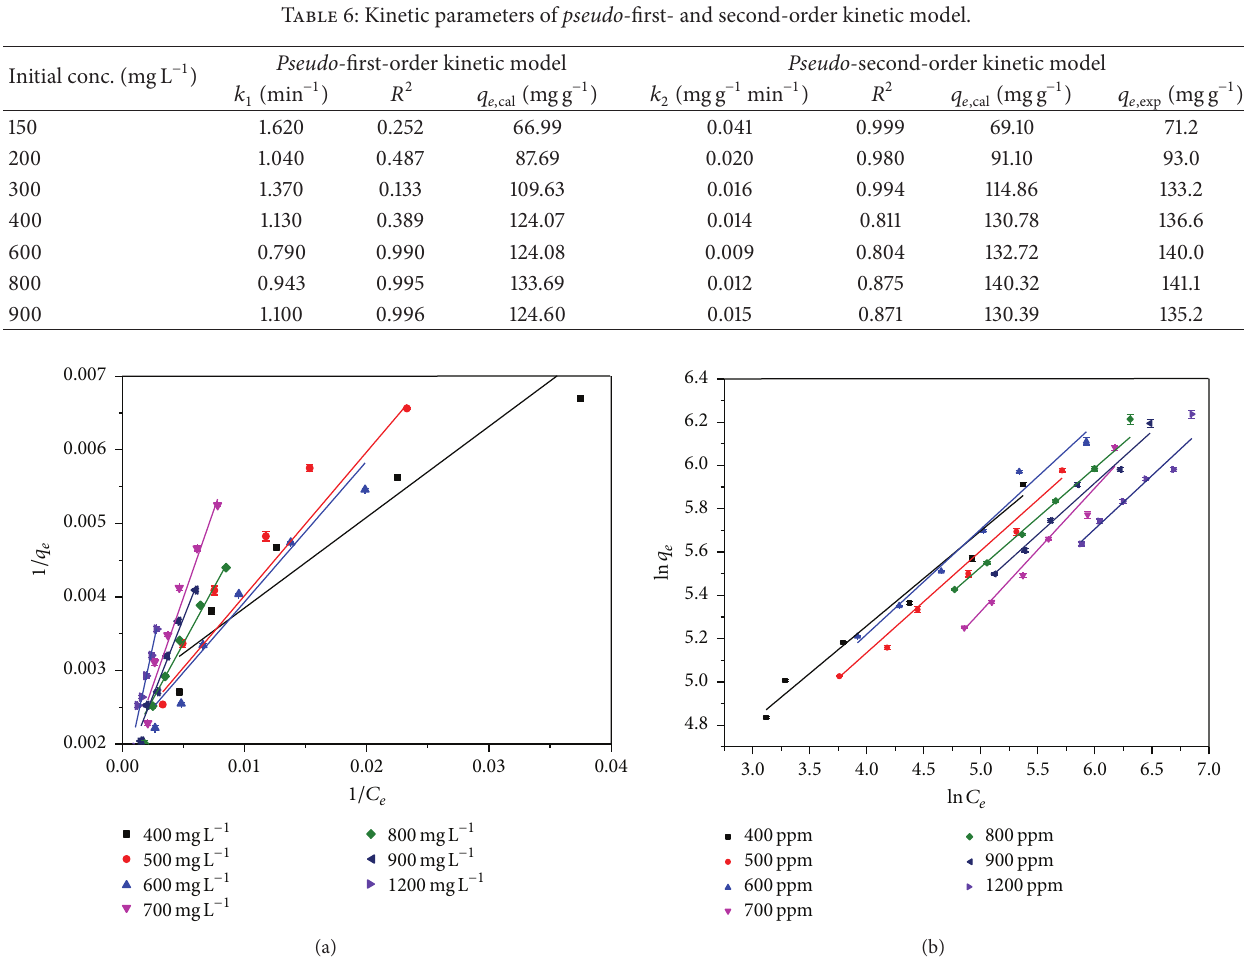
Figure 4: Plots of Langmuir (a) and Freundlich (b) adsorption isotherms for AB/diatomite system: adsorption condition: mass of adsorbent = 50; 100; 150; 200; 250; and 300 mg, volume of solution = 100mL, equilibrium time = 24 h, temperature = 25 ± 1 ∘ C, and pH of dyes solution =